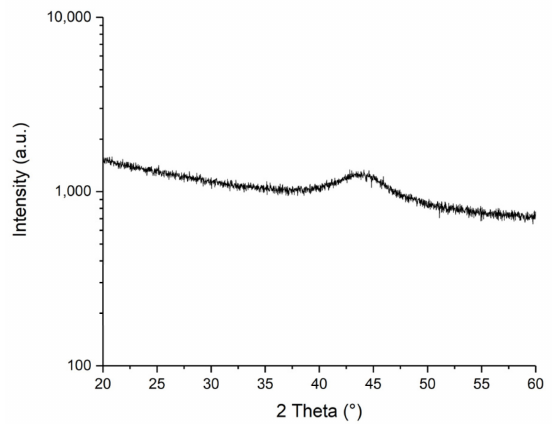
Figure 8. Result of the XRD measurement of the sputtered FeCuNbSiB, indicating its amorphous nature. The magnetization loops of samples with different thin film stresses between − 400 and 500 MPa were measured according to the described procedure. An example of the result is presented in Figure